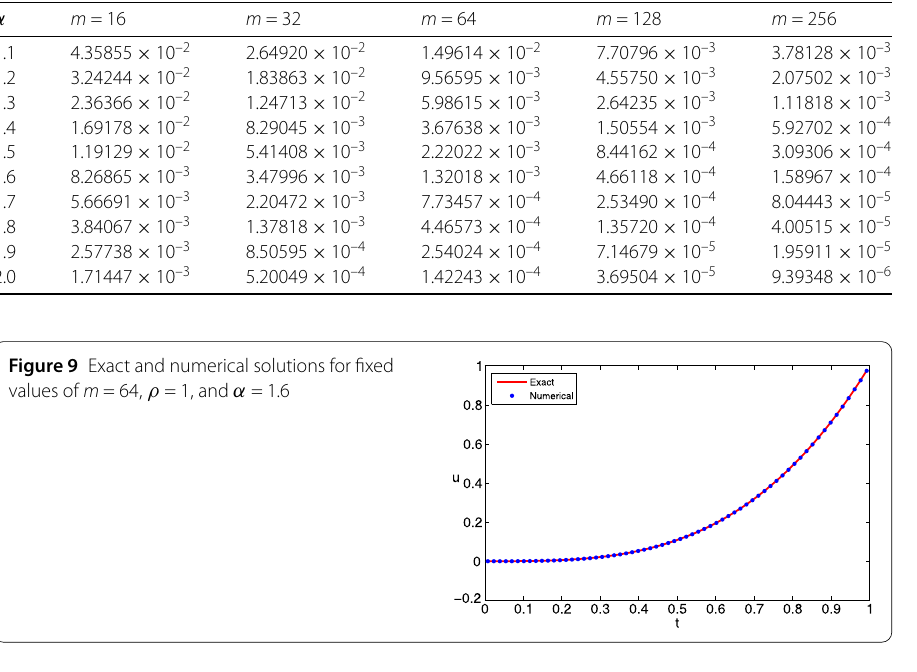
Table 8 Maximum absolute error for ρ = 1 and for different values of m and α α m = 16